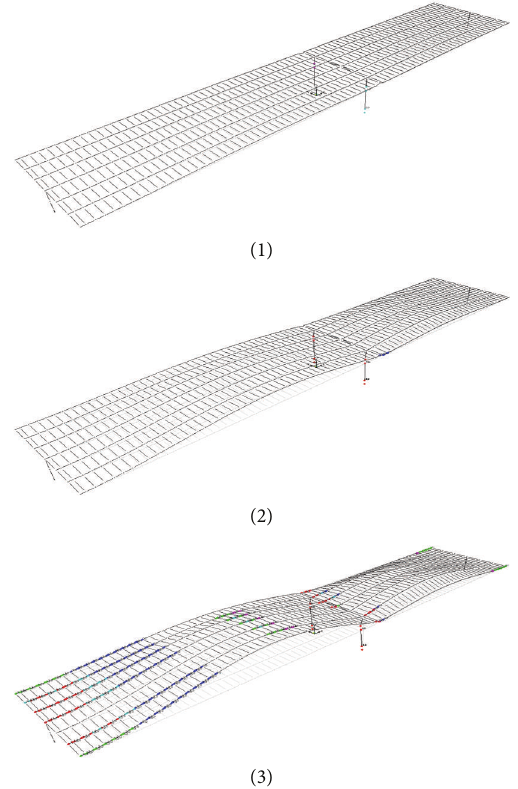
Figure 9: Analysis results for a case with fixed supports: monolithic connections in the abutments and central pier (obtained using nonlinear static